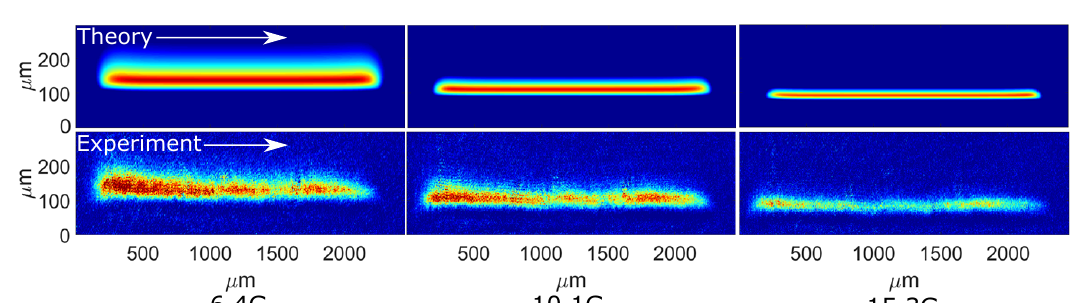
Figure 7: Zero-current-trap from left to right for a bias field of 6.4 G (0.64 mT), 8.9 G (0.89 mT), and 12.7 G (1.27 mT). (Top), simulated reverse potentials shown in colormap where blue to red corresponds to 5 G (0.50 mT) and 0.5 G (0.05 mT), respectively. The simulated potentials are calculated for the full 2D Z-wire structure using the current distribution in the inset of figure 5 inset for zero current all through out the wire cross-section. (Bottom), absorption image of the atomic cloud with a temperature 42 µ